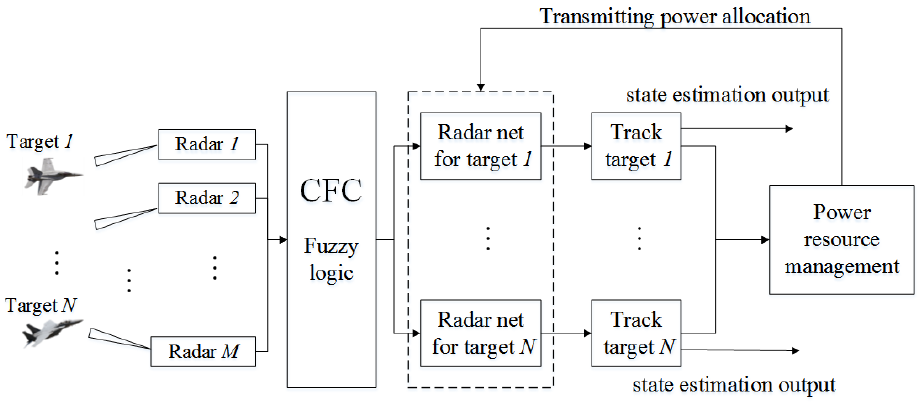
Figure 1. Radar network resource management process.